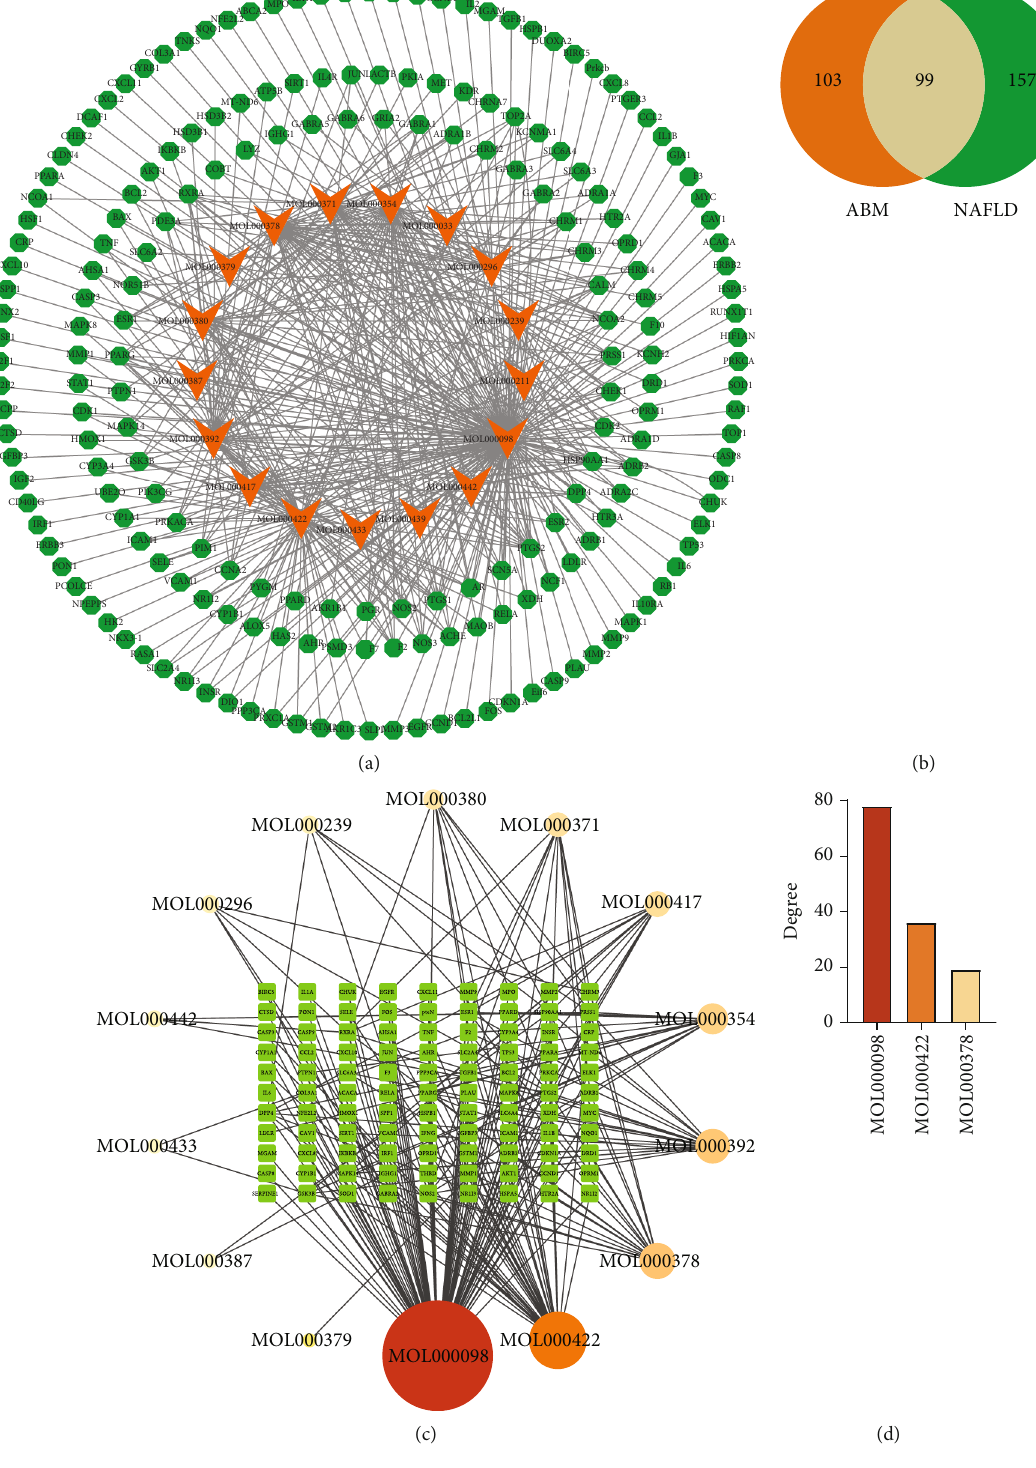
Figure 2: Compound-target network construction. (a) The component-target network of AMB. The orange triangles represent active compounds, and the green nodes represent component-related targets. (b) Venn diagram. The orange part represents the number of AMB targets, and the green part represents the number of NAFLD targets. (c) Compound-NAFLD targets network. The circular nodes represent potential active components in AMB, and the square represents the 99 common targets of AMB and NAFLD. (d) Degree of potential active